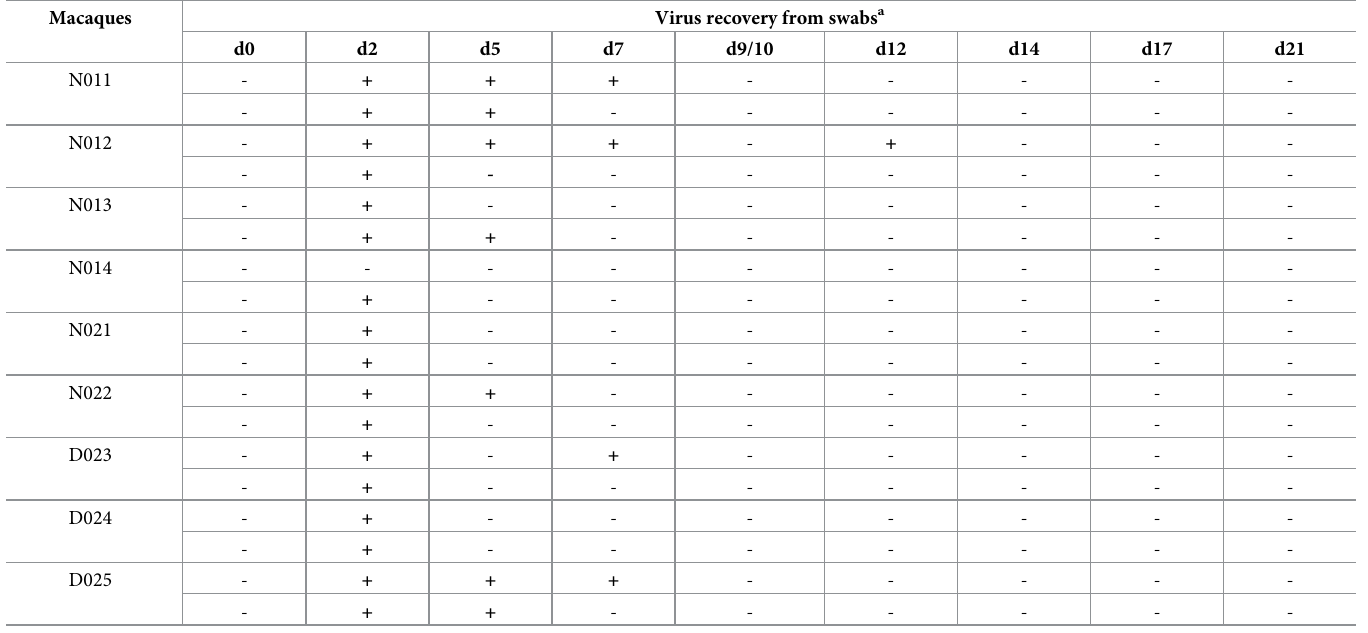
CD8 + T cells in the control of SARS-CoV-2 replication. However, it remains unclear whether SARS-CoV-2 replication can be controlled in the absence of CD8 + T cells. In the present study, we investigated the impact of depletion of CD8 + cells (including CD8 + T cells) by anti- CD8 antibody administration on SARS-CoV-2 replication in the subacute phase after estab- lishment of virus infection. Our results on viral RNA and virus recovery from pharyngeal swabs (Fig 2 and Table 2) indicate that viral replication was not contained when animals were treated with anti-CD8 antibody, while viral replication was controlled after the CD8 + cell depletion. We found no significant enhancement of viral replication or delay in viral clearance